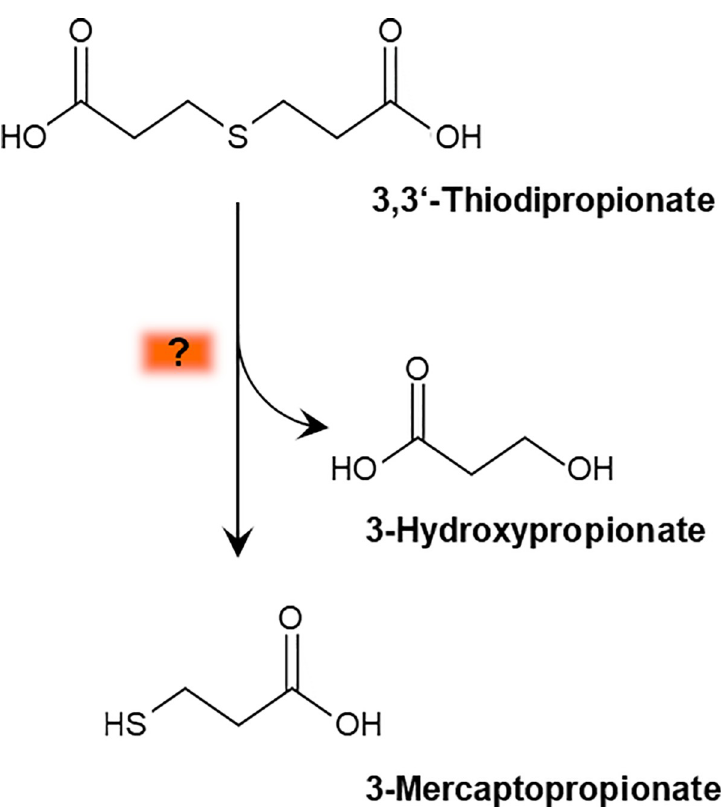
Fig 1. Synthesis of 3MP from TDP in V . paradoxus TBEA6. The cleavage of TDP has not been characterized until now.